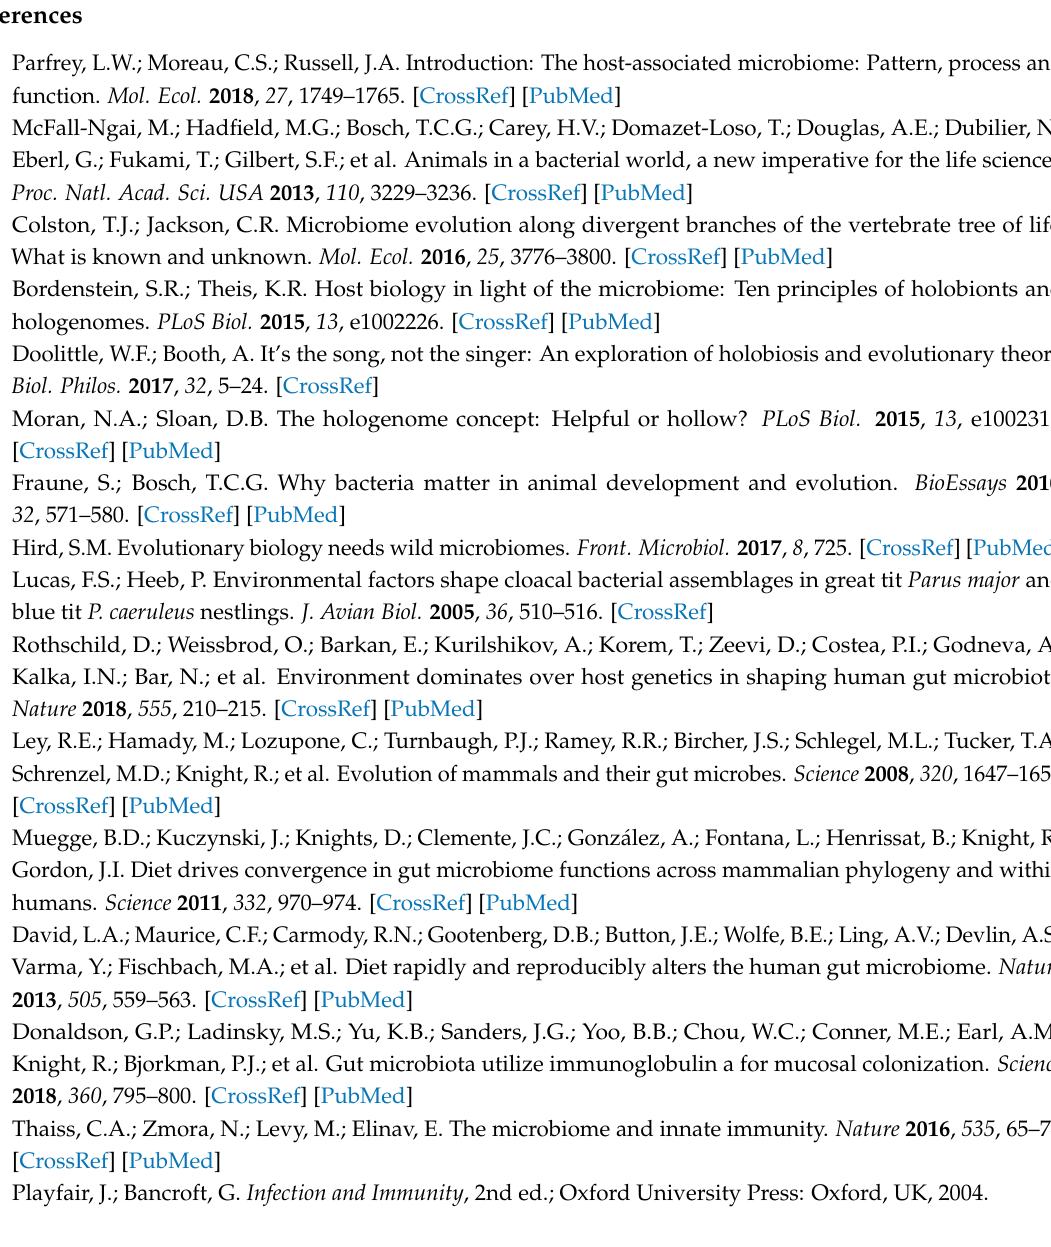
Table S1: Comparison of the abundances of each particular OTU among the cloacae samples obtained from adult and nestling great-spotted cuckoos as good as nestling magpies, Table S2: List of OTUs with a prevalence higher than 25% in any of the three types of samples, Figure S1: Tree reflecting the among-otus phylogenetic relationships for OTUs found in cloacae of great-spotted cuckoos and